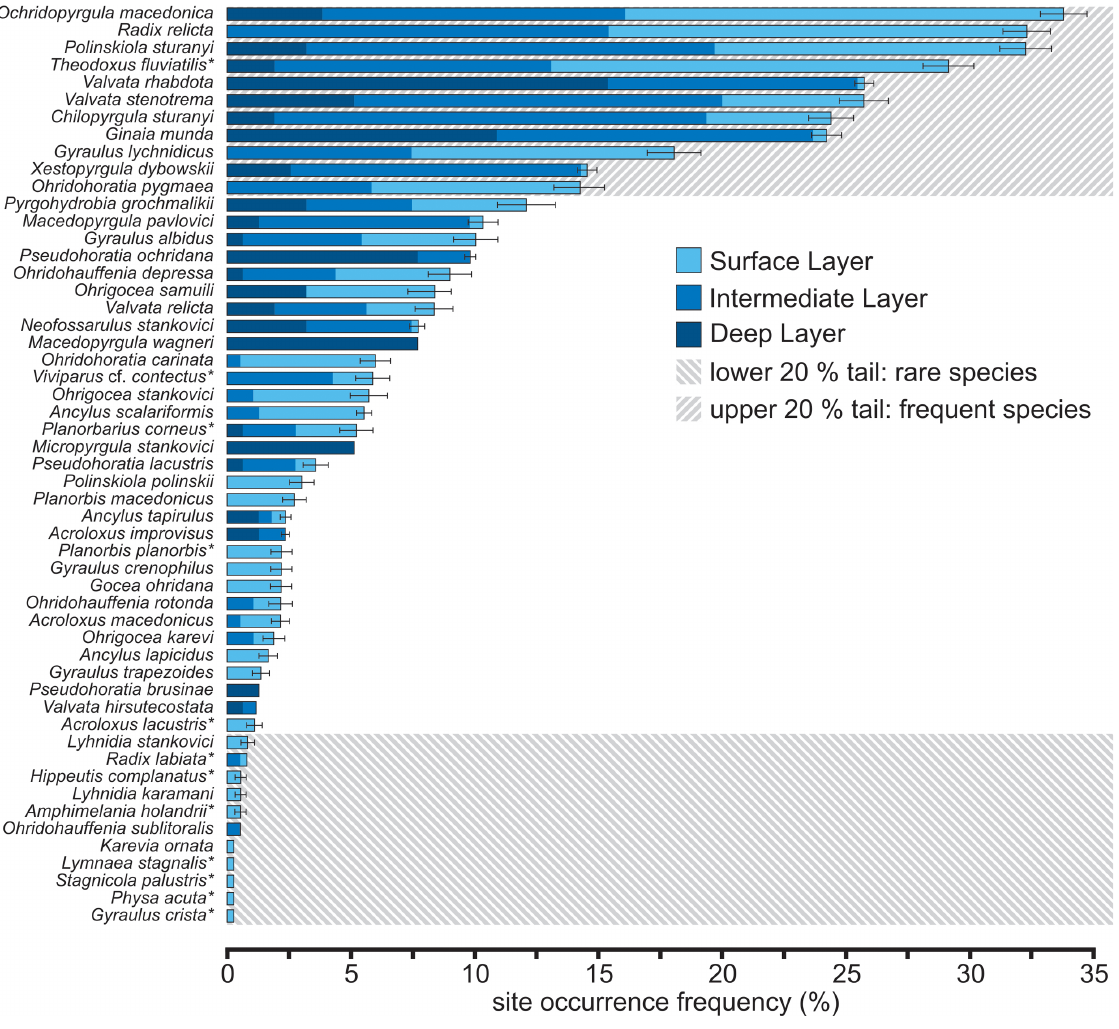
Fig. 2. Plot of frequency and standard deviation of species sites occurrence of gastropod species found in Lake Ohrid. Depth layers are colour-coded and widespread species are marked by